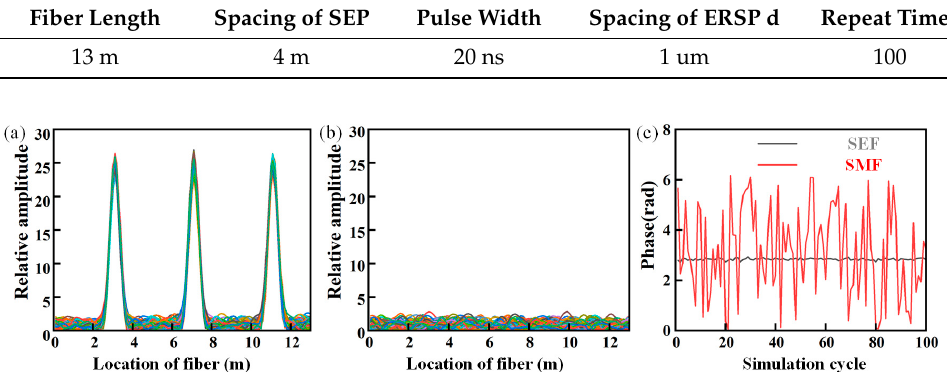
Figure 7. Simulation results of discrete enhanced scattering model: ( a ) reflection distribution of discrete enhanced fiber; ( b ) reflection distribution of single mode fiber; ( c ) phase demodulation result.